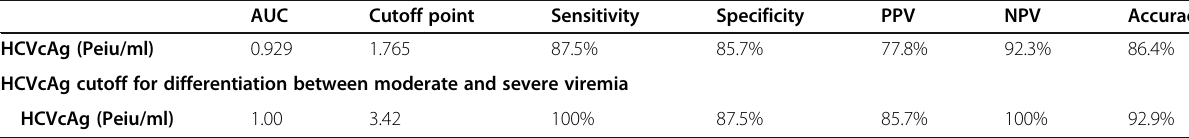
Table 4 HCVcAg cutoff for differentiation between mild and moderate